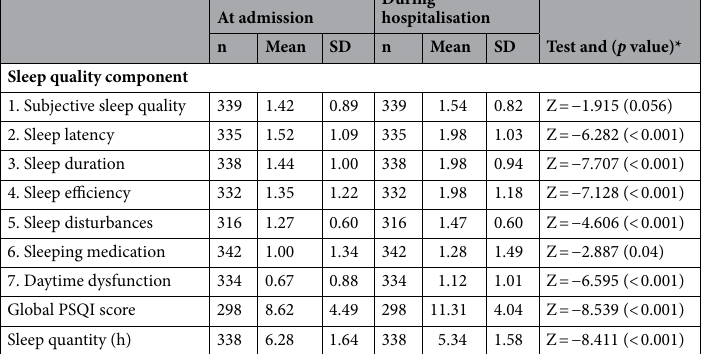
Table 2. Sleep quality and quantity at admission and during hospitalisation. SD standard deviation *Student’s paired t-test or Wilcoxon